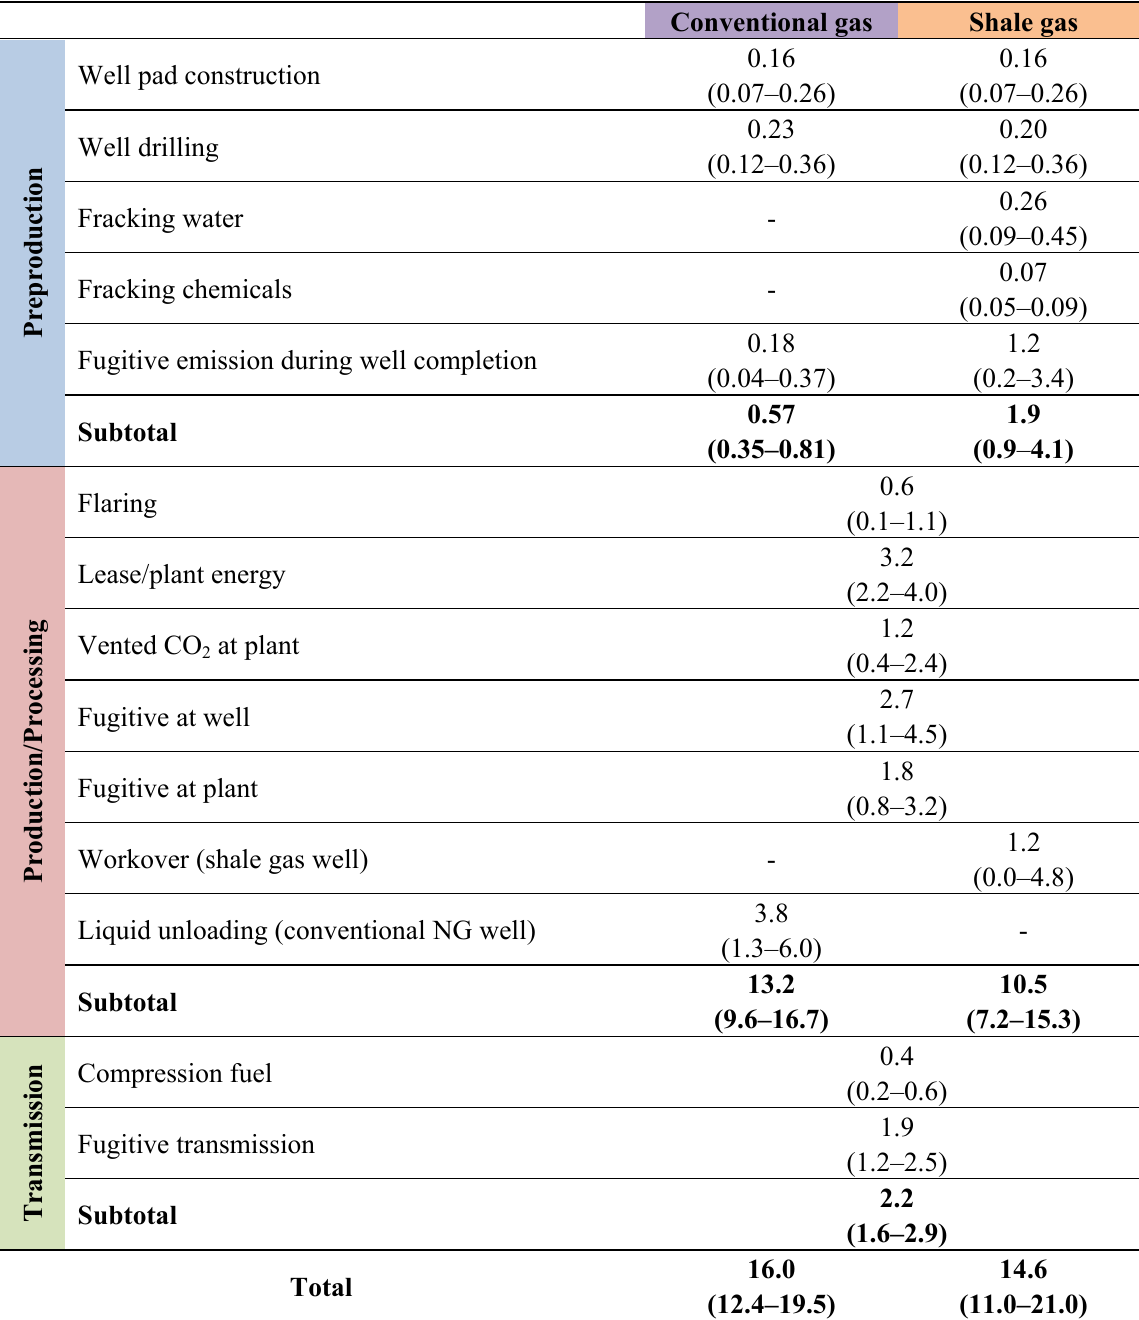
Table 3. Comparison of statistical results of mean carbon footprints for each emissions category between conventional NG and shale gas. These results were derived from a Monte Carlo simulation using the triangular distribution formed from the minimum, most likely, and maximum values shown for each category shown in Table 1. The 95% probability interval is shown in parentheses for each category. Note that conventional NG is assumed to have the same carbon footprints related to energy inputs with the exception of those associated with hydraulic